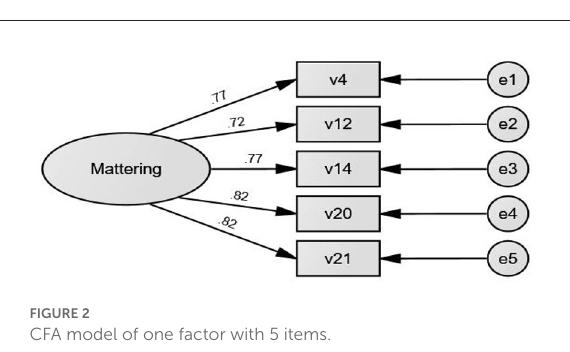
FIGURE2 CFA model of one factor with 5